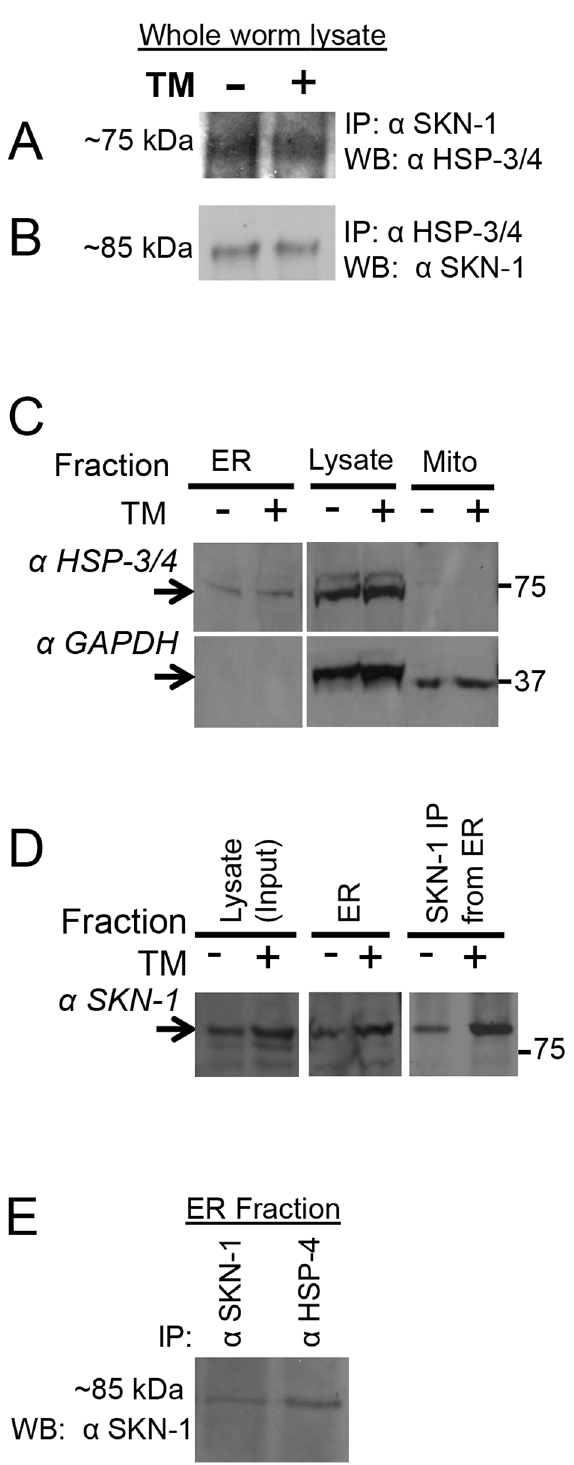
Figure 6. Association of SKN-1 with the ER. (A, B) Interaction between endogenous SKN-1 and HSP-3/4, detected by IP/Western. Lysates were prepared from animals in which proteins had been crosslinked under ChIP conditions. (A) Monoclonal a SKN-1 IP blotted with a Hsc3 (HSP-3/4). (B) a Hsc3 (HSP-3/4) IP blotted with monoclonal a SKN-1. (C–E) Analyses of ER fractions prepared from whole worms. The fractionation scheme is described in Fig. S6B. (C) Detection of endogenous HSP-3/4 and the cytoplasmic marker GAPDH in ER and Mitochondrial fractions, and total worm lysate. Note the enrichment